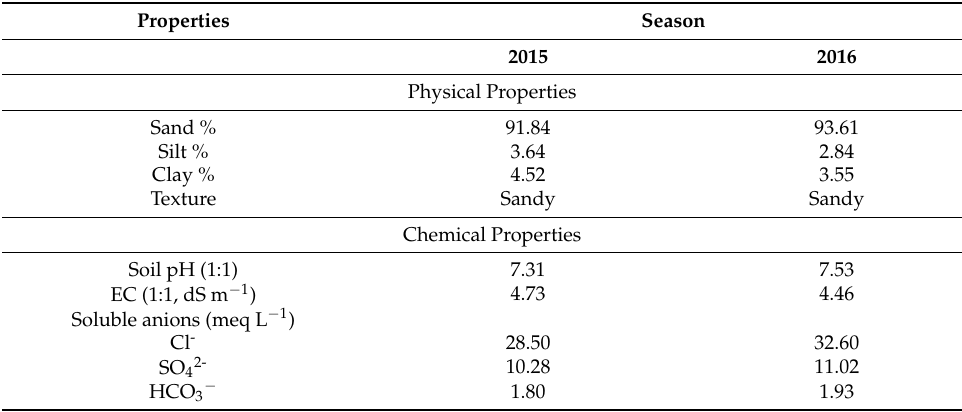
Table 2. Soil properties of the study site in the 2015 and 2016